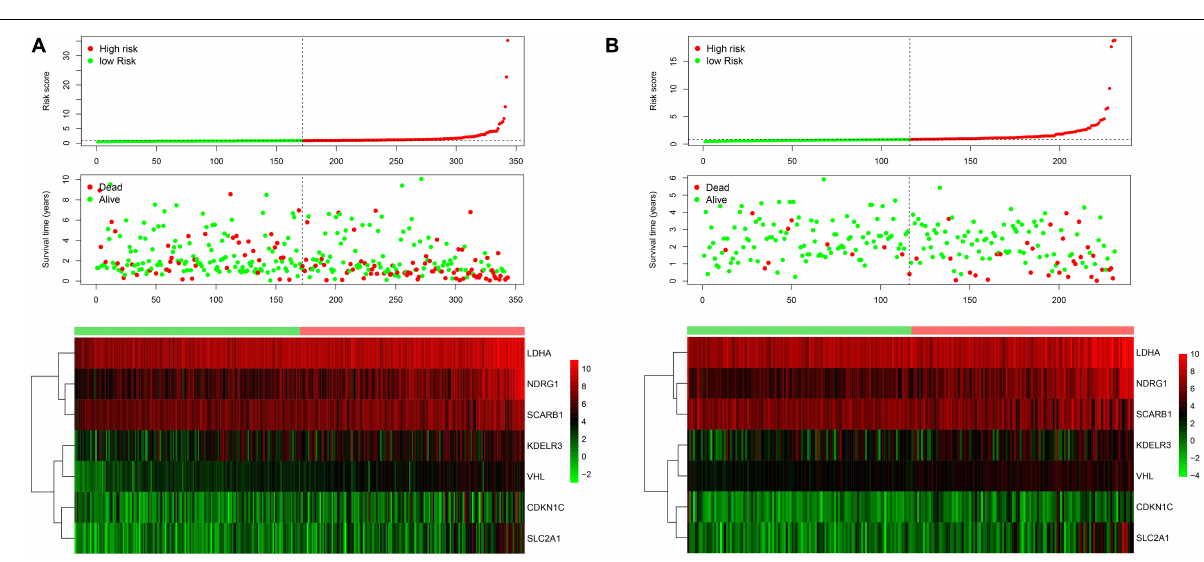
Frontiers in Genetics |